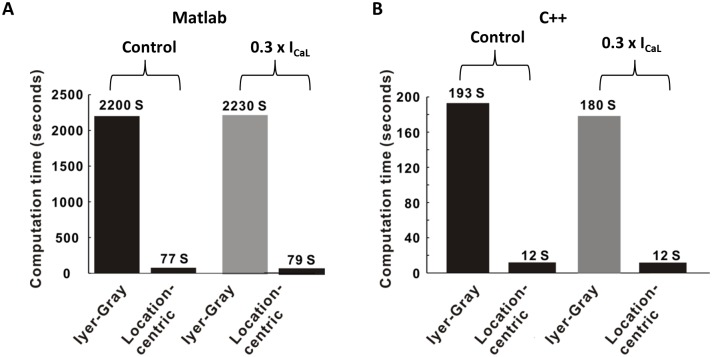
Comparison of computational times for PS calculations.PS calculation times when using the two methods for a 1-s simulation: for the control and remodeling (0.3×ICaL) scenarios. We tested programs with the Matlab package and C++.